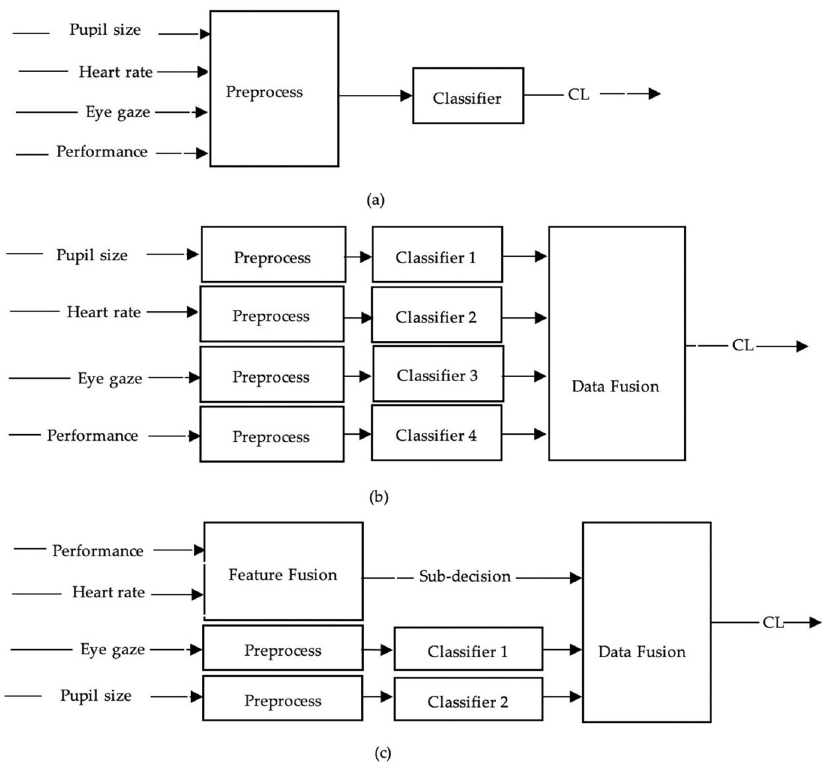
Fig 2. The structures of the data fusion methods. A feature-level fusion (a), a decision-level fusion (b), and a hybrid- level fusion (c).